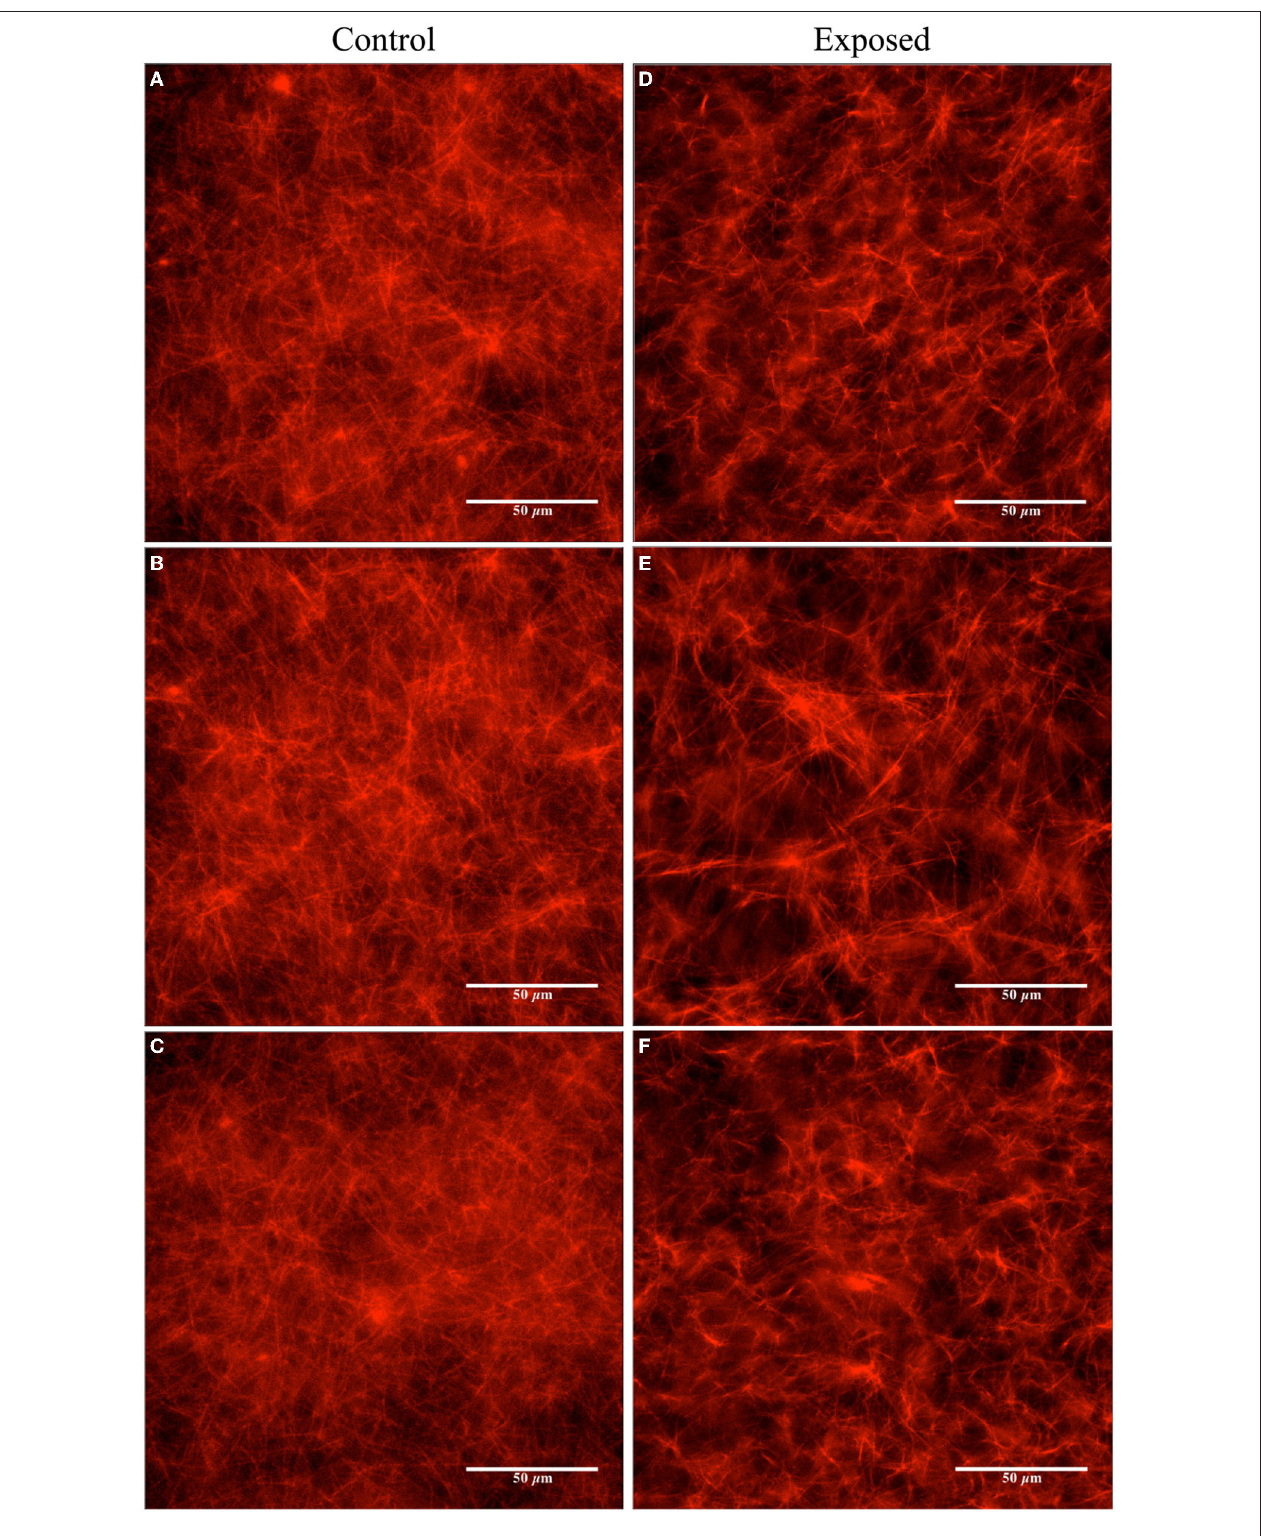
FIGURE 6 | Fluorescence microscopy images obtained for the unexposed and the Vielight LED-exposed MTs (labeled with rhodamine) stabilized in PEM-T (20 µ M Taxol and ∼ 2 µ M tubulin). The control group is shown on the left (A–C) and the exposed (2 h) on the right (D–F) . Images are representative of N = 1 independent replicate